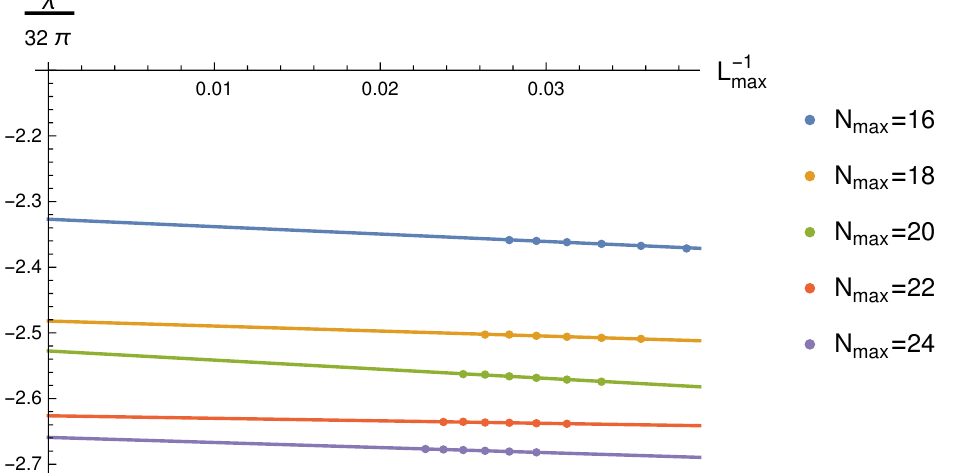
Figure 4 . Lower bound on the quartic coupling λ as a function of L − 1 numerical results. The solid lines represent the linear extrapolation in L − 1 points for each N max . Different colours correspond to different values of N max indicated in the right-hand side of the